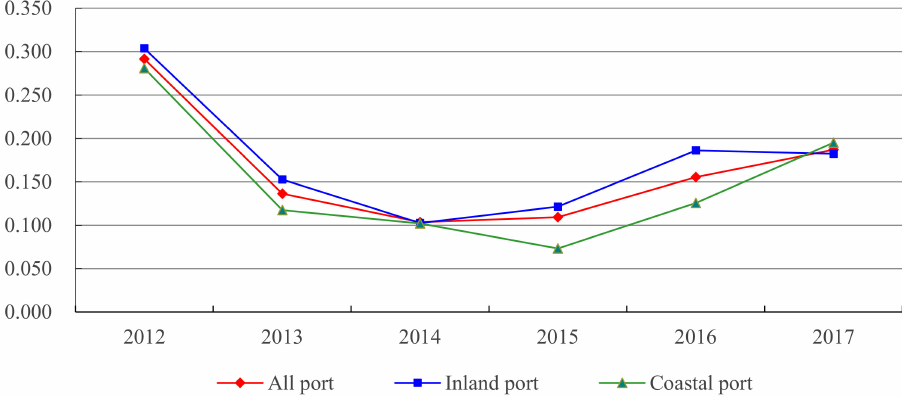
Figure 5. Variation trend of green TFP difference degree in general, inland and coastal ports.